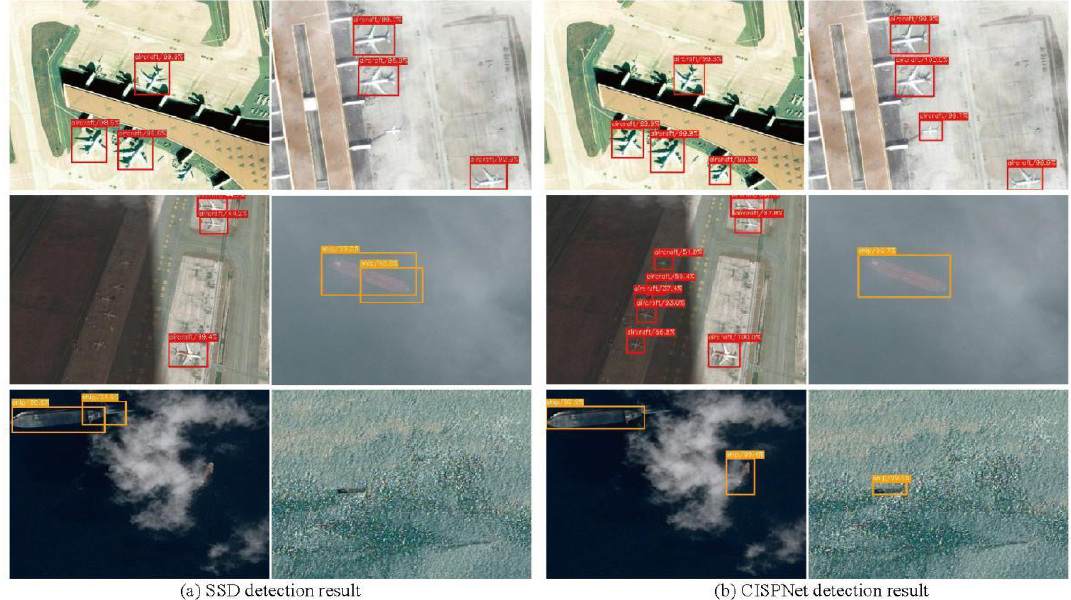
Figure 9. Fuzzy targets detection examples on the remote sensing image test dataset with SSD and CISPNet models. ( a ) The results of the SSD. ( b ) The results of CISPNet.